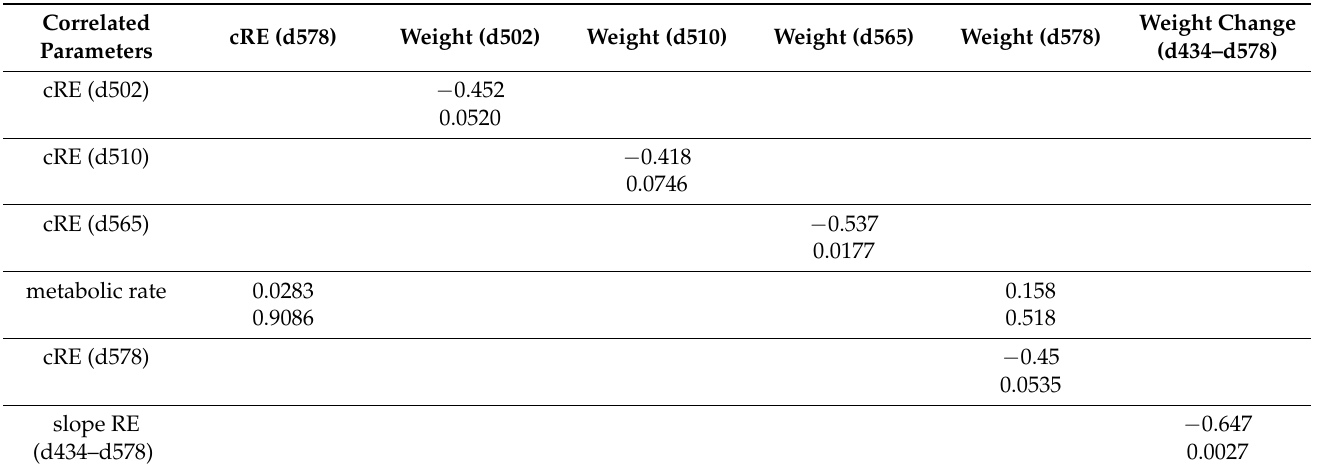
Table A1. Correlation results between measured parameters during the housing in the SNE and the recorded activity of 19 mice. The table shows the correlation factor r and the respective p-value below of each comparison made. Depending on an existing normal distribution the factor was calculated by the correlation methods according to Pearson or Spearman. Grey areas = p -values, that indicate a significant correlation between two parameters (uncorrected). If a parameter was used more than once for correlation analysis, the alpha mistake decreased by a n − 1 according to Bonferroni